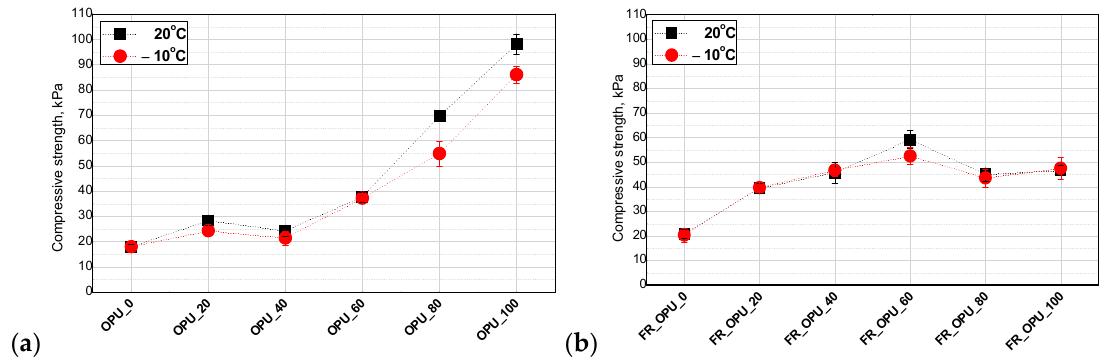
Figure 4. Influence of bio-polyol ( a ) and both bio-polyol and flame retardant ( b ) on compressive strength of open-cell PUR foams.